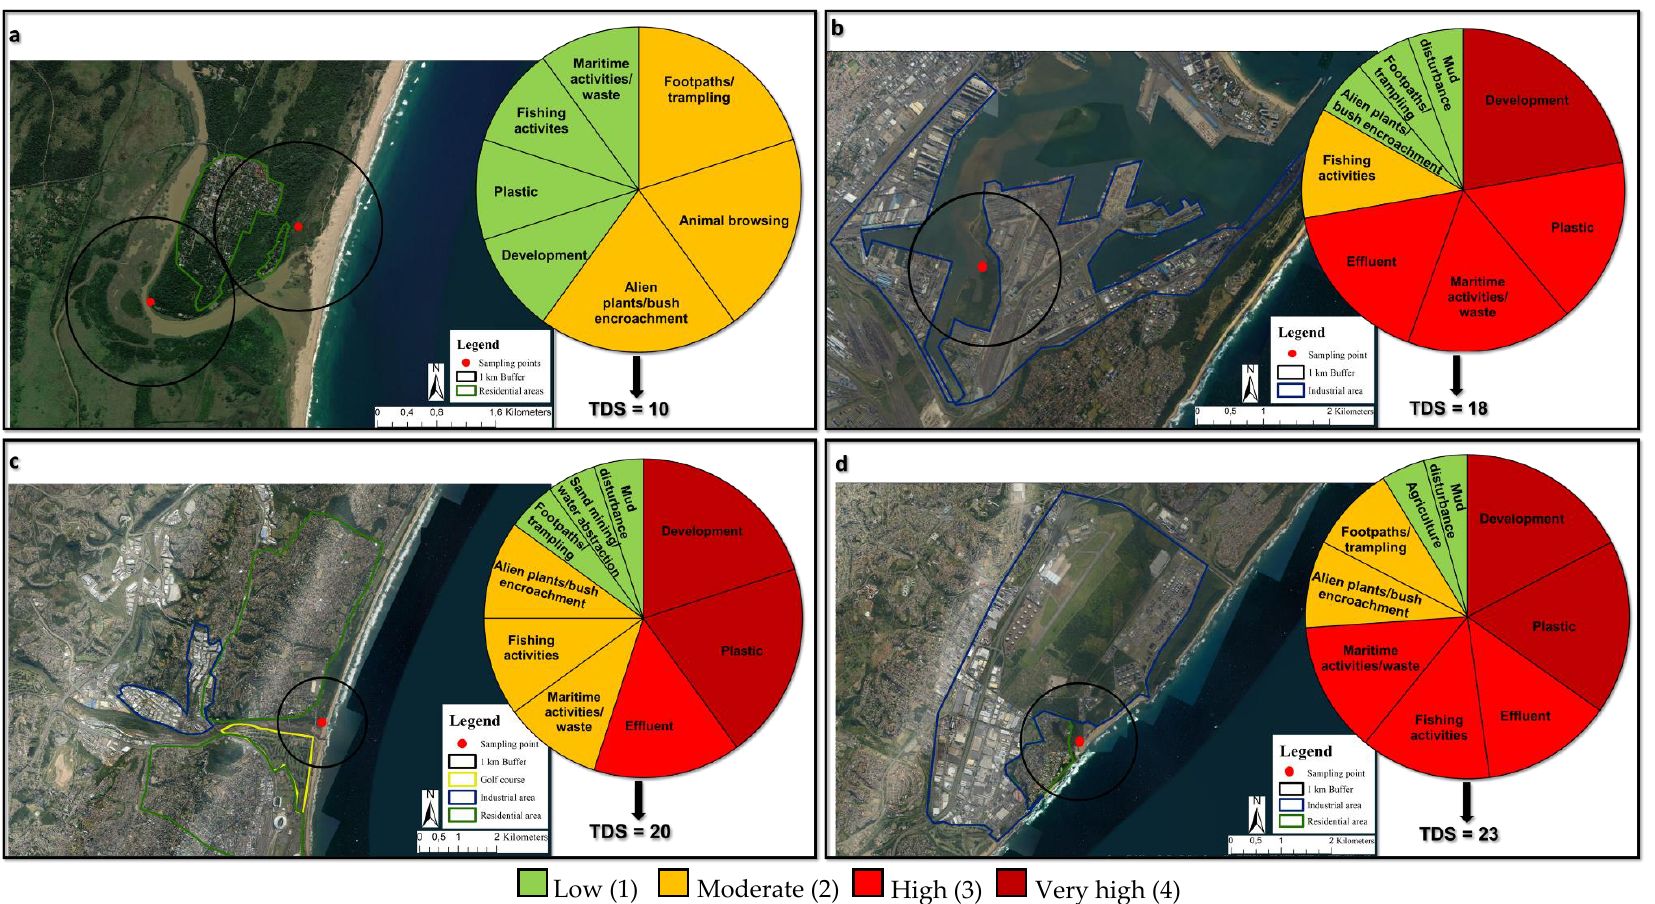
Figure 2. Land use types surrounding (within 5 km) each estuary and pie charts showing the types and severity of disturbances impacting on them. The pie chart reflects the proportional contribution of each disturbance type to the total disturbance score (TDS; potential maximum of 48) for the ( a ) St. Lucia, ( b ) Durban Harbour, ( c ) uMgeni and ( d ) Isipingo estuaries. The TDS is the sum of the average score for 12 disturbance types, scored in terms of severity (from 1 to 4) by three observers on each of four days (n = 12) at each site.